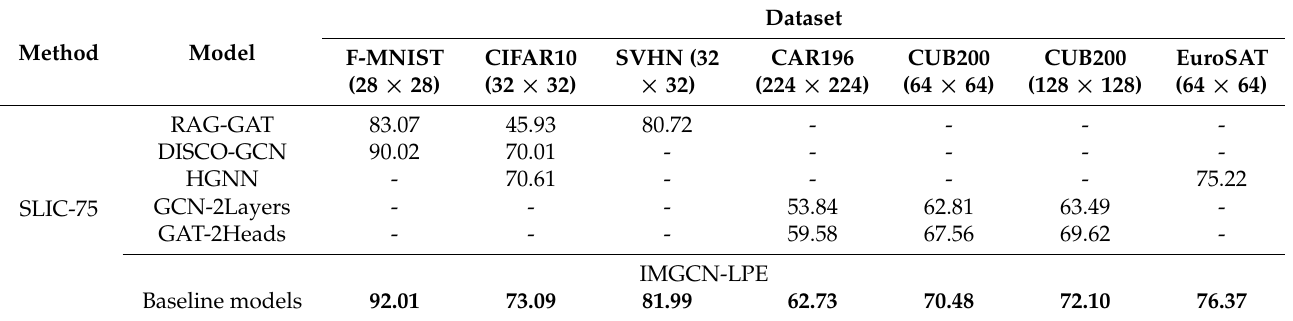
Table 2. Compared to the previous state-of-the-art models, the IMGCN-LPE method in FashionMNIST is about 2% higher than the DISCO-GCN, about 2.5% higher than the HGNN in CIFAR10, and about 1.2% higher than the HGNN in EuroSAT. For CAR196 and CUB200-2011, IMGCN-LPE is better by about 1.9% to 2.5% compared to the baseline models. Table 2. Comparison of the experimental results with related